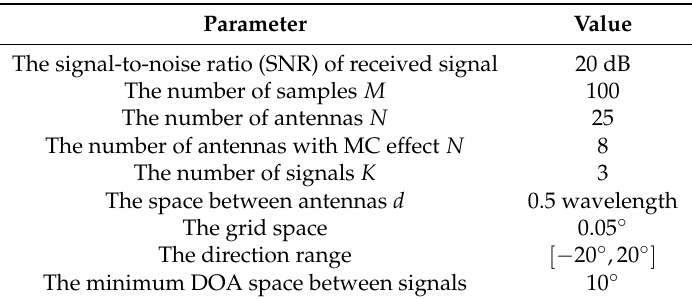
Table 1. Simulation